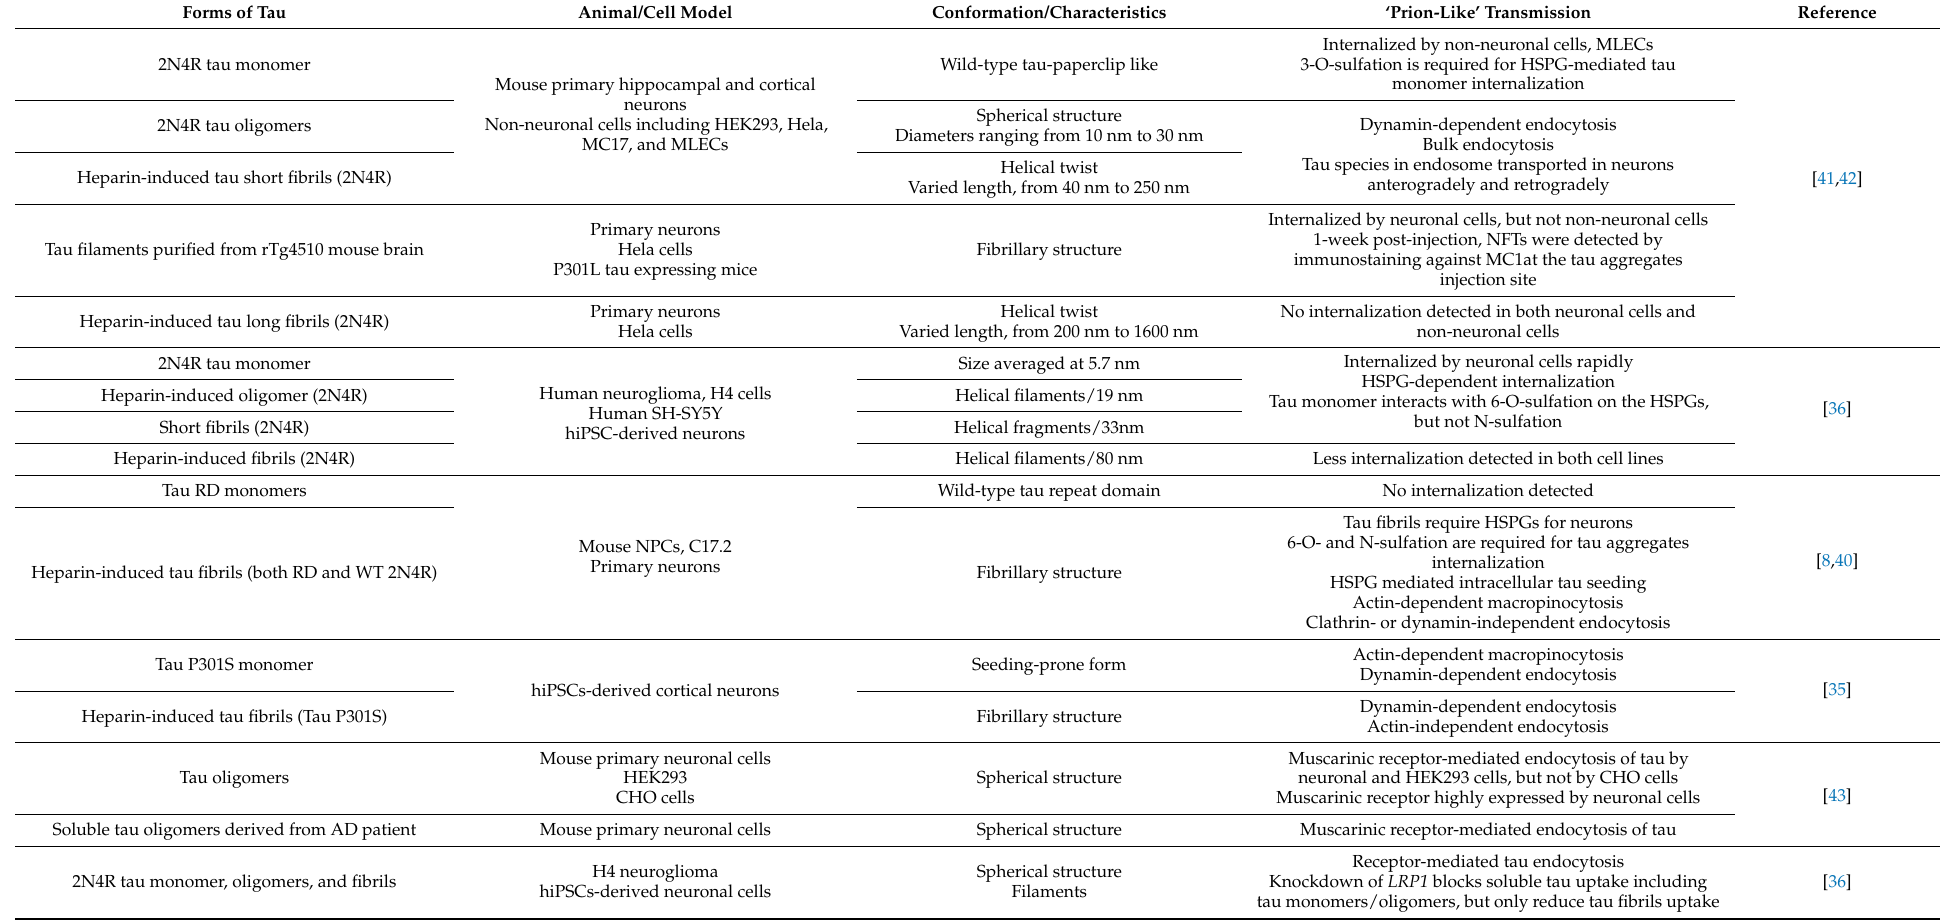
Table 2. A summary of recent tau transmission